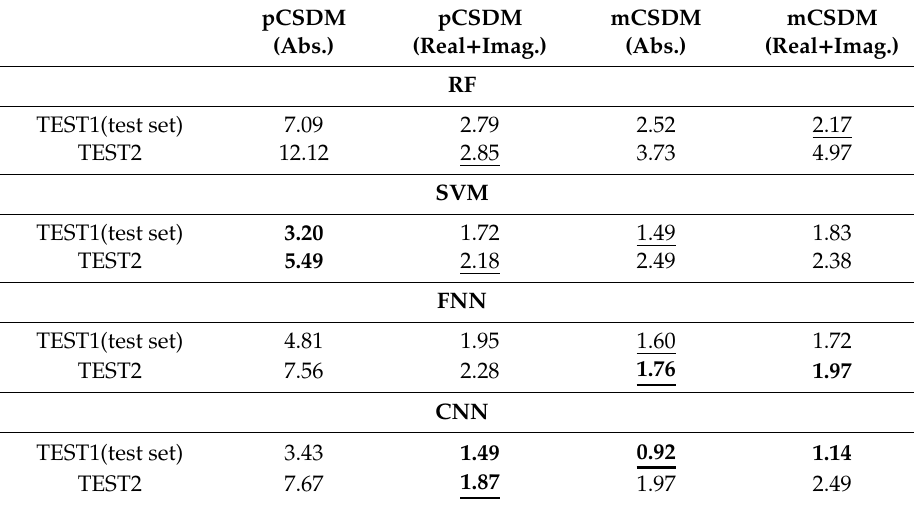
Table 2. Classification results (percent error). The bold font indicates the minimum percent error among four machine learning algorithms for each dataset. The underscore shows the best result for each algorithm. pCSDM pCSDM mCSDM (Abs.) (Real + Imag.) (Abs.) (Real +